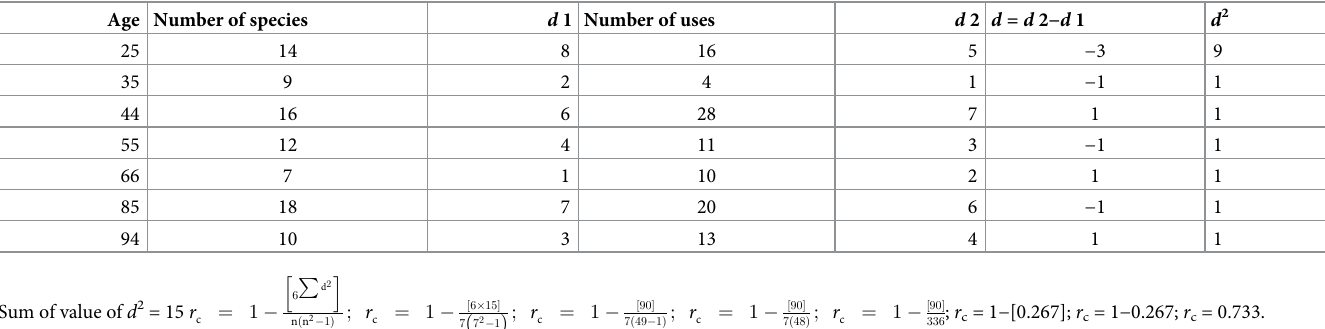
Table 7. Spearman correlation for Male informants from Dawarian and Rati Gali, AJK, Pakistan. Age Number of species d 1 Number of